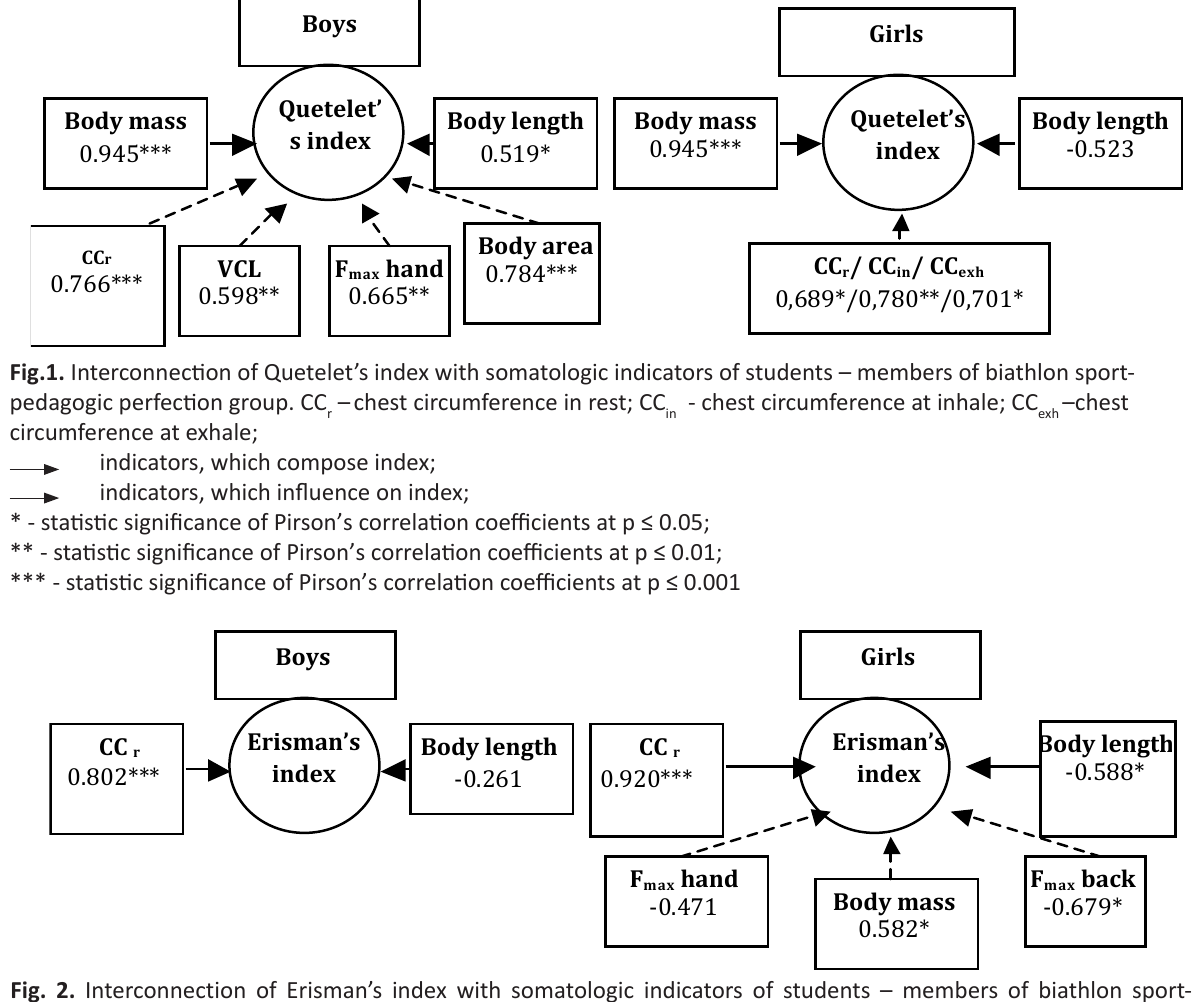
Fig. 2. Interconnection of Erisman’s index with somatologic indicators of students – members of biathlon sport- pedagogic perfection group. CC – chest circumference in rest; r indicators, which compose index; indicators, which influence on index;